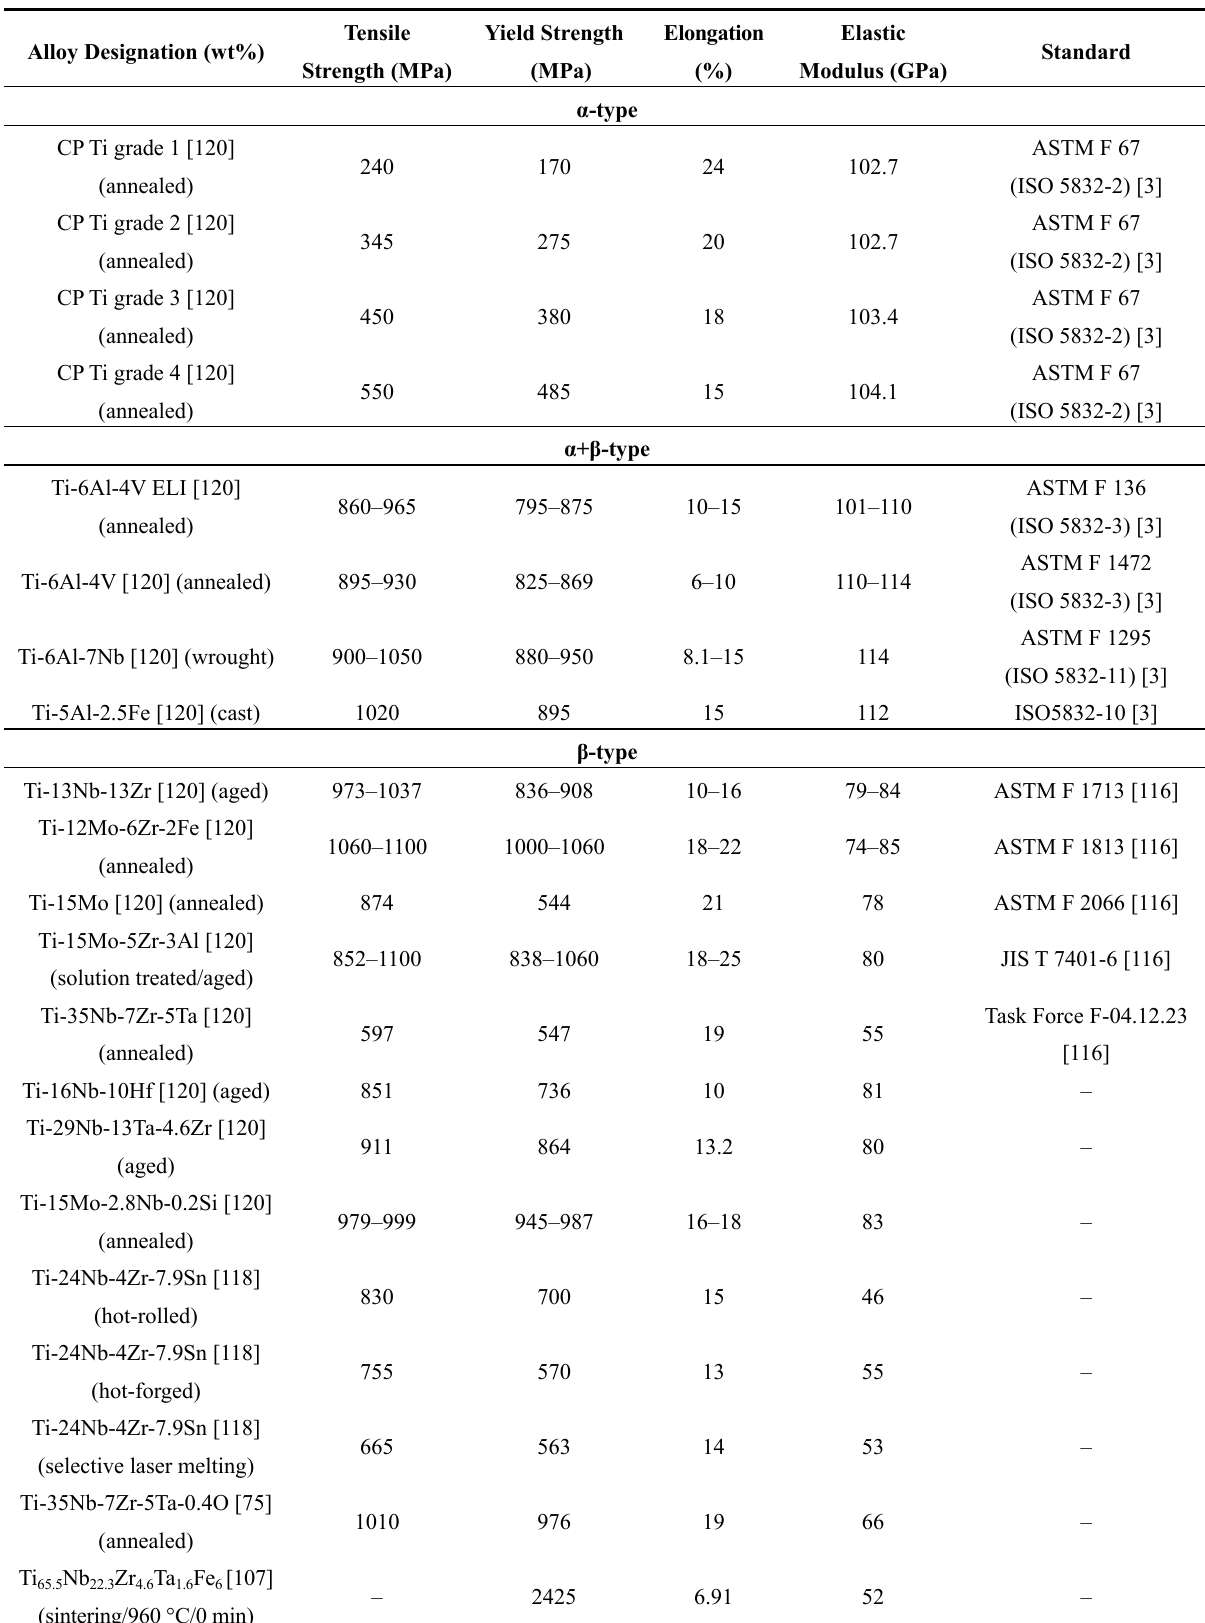
Table 4. Mechanical properties of typical α -, α + β - and β -type Ti-based alloys for biomedical